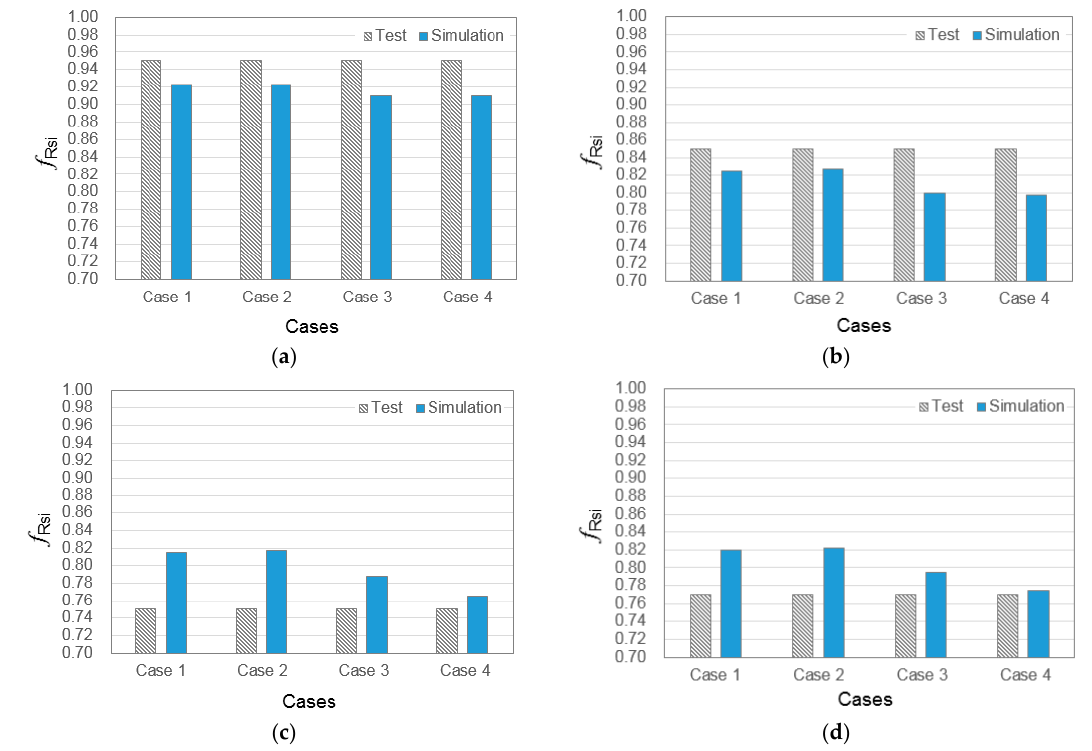
Figure 11. Measured and calculated temperature factors ( f Rsi ) according to the surface thermal resistance: ( a ) center-of-glazing (C-1); ( b ) frame (F-2); ( c ) edge-of-glazing (E-1); and ( d ) edge-of-glazing (E-2).